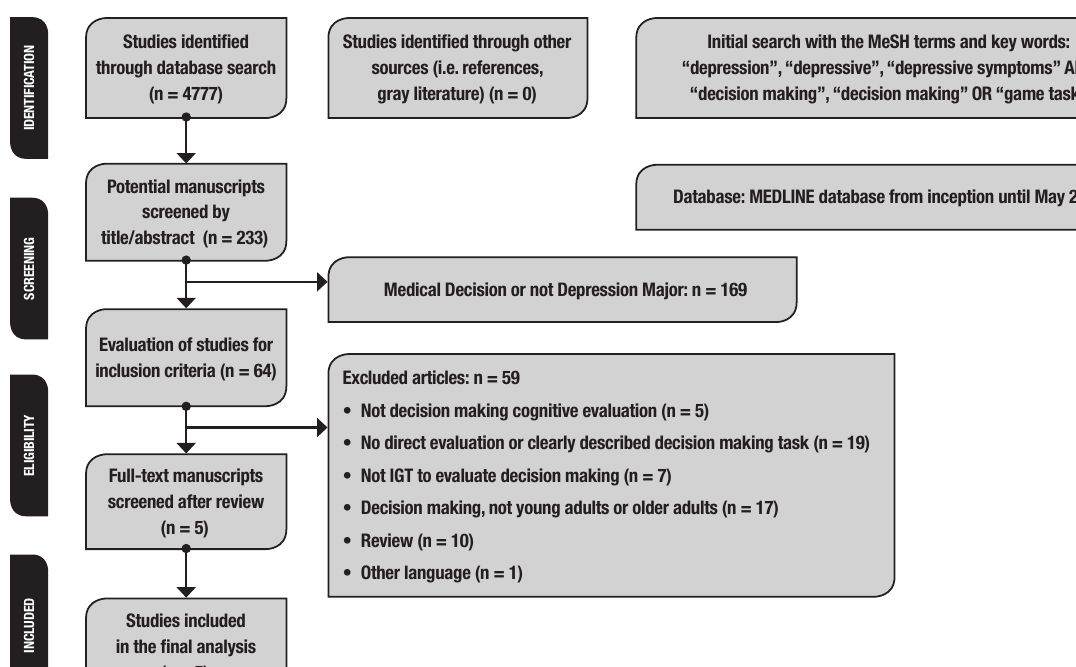
Figure 1. Flow diagram of the systematic